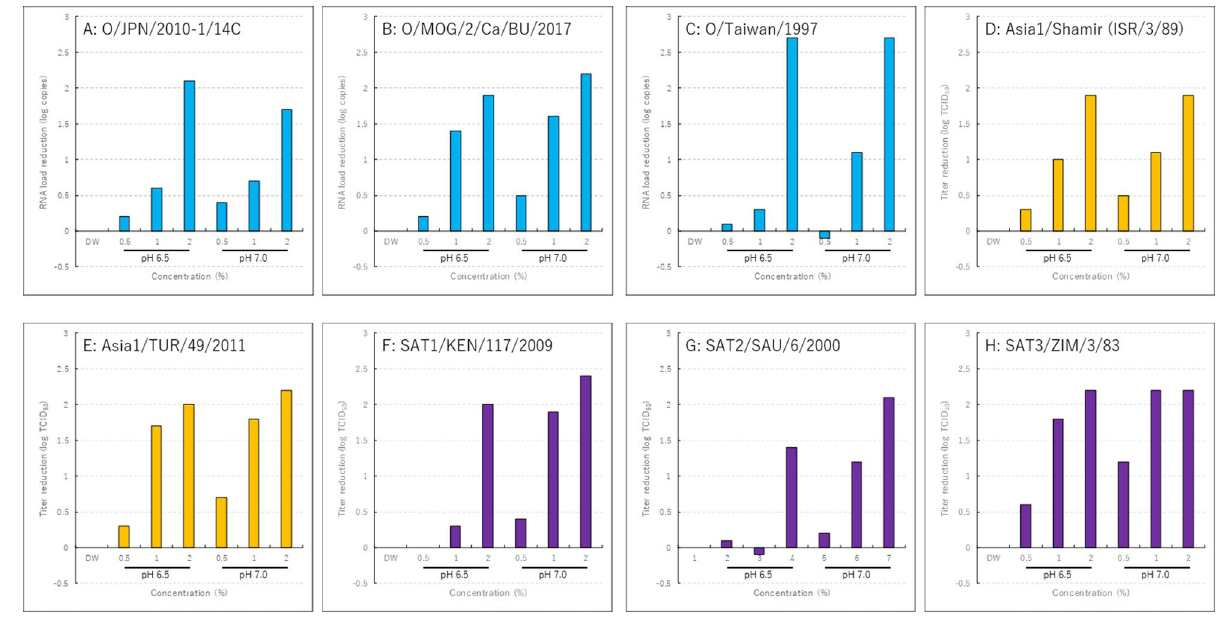
Figure 2. Relationship between concentration of the heat-denatured lysozyme and the RNA load of FMDVs. ( A ) O/JPN/2010-1/14C, ( B ) O/MOG/2/Ca/BU/2017, ( C ) O/Taiwan/1997, ( D ) Asia1/Shamir (ISR/3/89), ( E ) Asia1/TUR/49/2011, ( F ) SAT1/KEN/117/2009, ( G ) SAT2/SAU/6/2000, ( H ) MNV or MNV incubated with native lysozyme 8 . Therefore, changes of the conformations of capsid proteins increase the size of the virion, which accounts for the mechanism of inactivation of MNV by heat-denatured lysozyme. In addition, antiviral activity of lysozyme appears to be independent from its bacteriolytic activity, and is related to its positive charge that induces instability in cellular membranes 6,18 . Egg white lysozyme stops the typical cell fusion induced by herpes simplex virus; however, addition of negative charges to this molecule drastically reduced its antiviral activity 18 . Furthermore, the hydrophobicity of heat-denatured lysozyme tends to increase as the pH increased and contributes to MNV inactivation by heat-denatured lysozyme 19 . Further investigations are required to determine whether FMDV is inactivated through a similar mechanism. The amino acid sequences of lysozyme and α-lactalbumin are approximately 70% identical 20 , which is reflected by their similar secondary structures. Although the structural properties of lysozyme and α-lactalbumin are similar (secondary and tertiary structures, constituent amino acid ratios, and specific amino acid regions), the latter does not inactivate MNV 8 . These results suggest that inactivation of MNV by heat-denatured lysozyme is caused by a specific domain within lysozyme, rather than its entire structure. When the amino acid sequence of lysozyme was divided into three regions according to its secondary structure, one polypeptide inhibited MNV significantly more than the other peptides. Further, there is no significant difference between the inhibitory activi- ties of the native and heat-denatured peptides, indicating that the primary amino acid sequence is responsible for inactivation of MNV. In addition, heat denaturation may also change the conformation of lysozyme, which confers its inhibitory activity. In contrast, α-lactalbumin lacks a corresponding sequence, which likely accounts for its inability to inactivate MNV. Here we show that heat-denatured lysozyme did not significantly reduce the infectivities of FMDVs A/TAI/46- 1/2015 and Asia1/Shamir (ISR/3/89), and it did not sufficiently reduce the RNA loads of FMDVs O/JPN/2000, A/ TAI/46-1/2015, A 22 /IRQ/24/64, A 15 /TAI/1/60 and C/PHI/7/84. These FMDV strains are not identical; however, heat-denatured lysozyme reduced the titers/RNA loads of serotype O strains O/JPN/2010-1/14C, O/MOG/2/